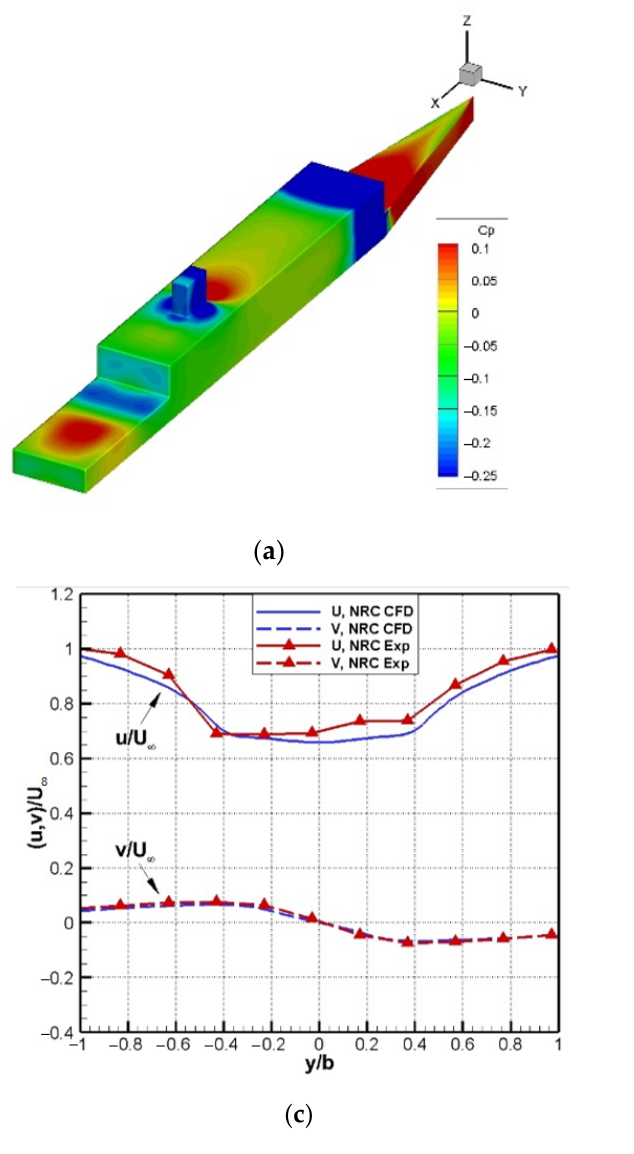
Figure 1. Computed results for the SFS 2 model at headwind condition (Yuan et al. [14]). ( a ) Pressure distribution on ship surface. ( b ) Pressure distribution on the mid-plane. ( c ) Mean velocity. ( d ) Power spectra of the streamwise velocity.